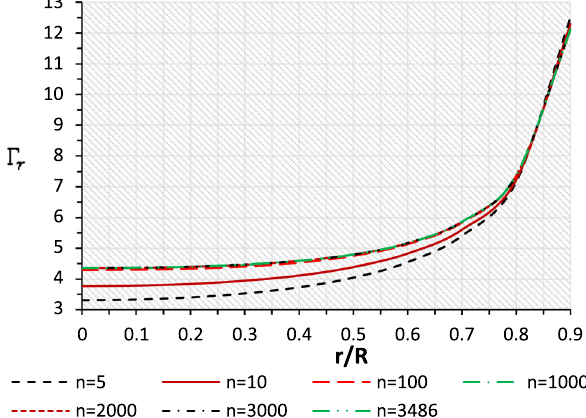
Fig. 9 Variation of adiabatic index (Γ r ) vs. radial coordinate r / R with different values of n for LMC X −